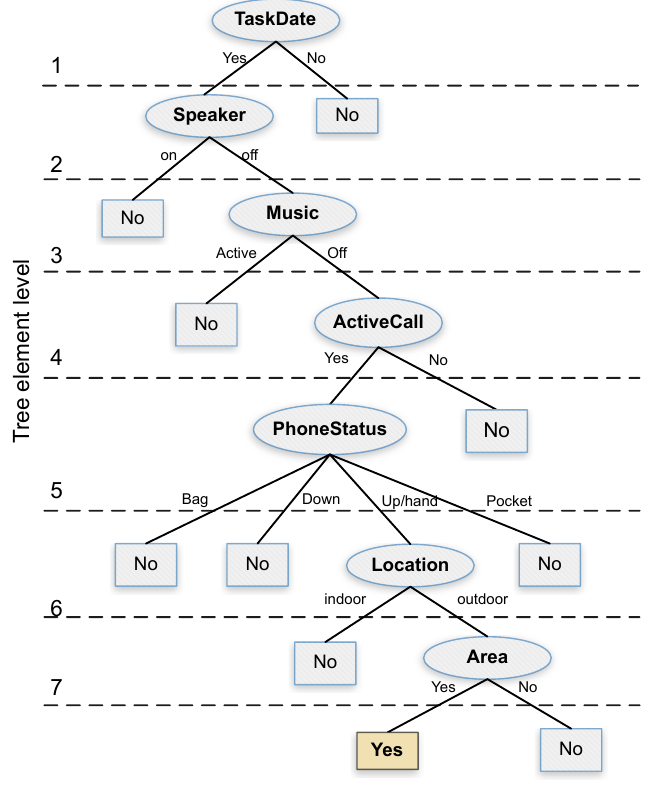
Figure 7. Proposed resource-efficient decision